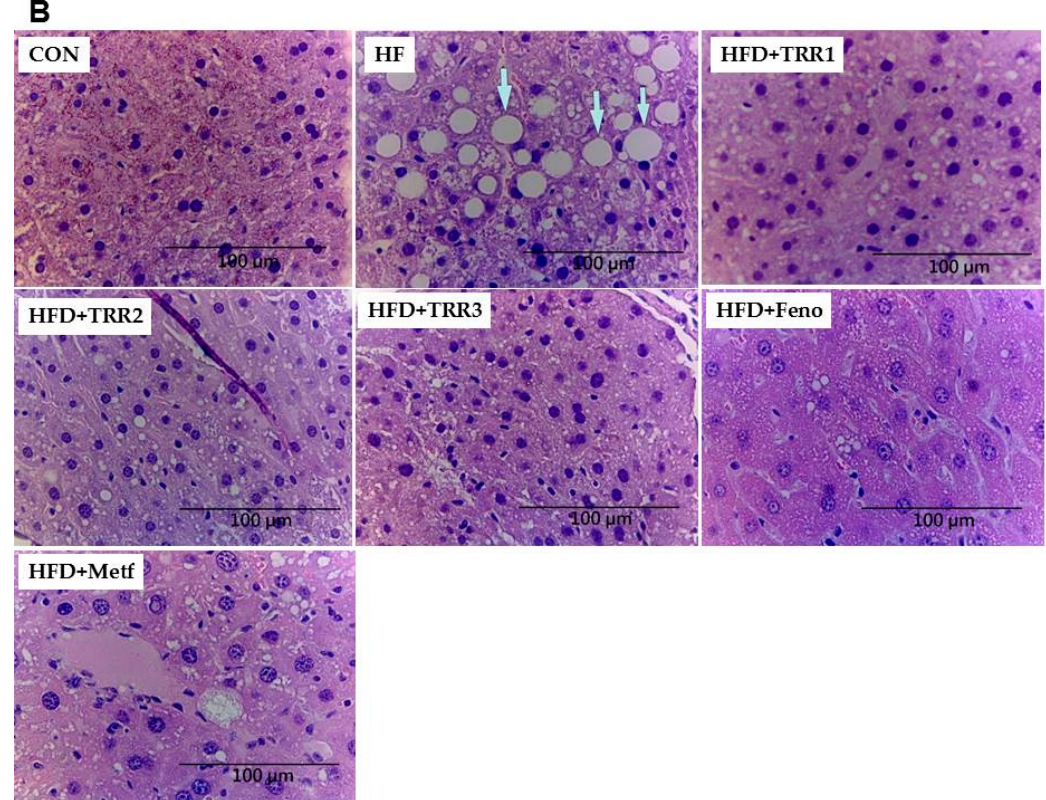
Figure 4. Histology of ( A ) epididymal white adipose tissue and ( B ) liver tissue of mice in the control (CON), high-fat-diet plus vehicle (distilled water) (HF), HFD + TRR1, HFD + TRR2, HFD + TRR3, HFD + fenofibrate (Feno), or HFD + metformin (Metf) groups by hematoxylin and eosin staining. Arrows indicated the hepatic ballooning degeneration. Each presented is typical and representative of nine mice, and one section per mouse. TRR1, TRR2, or TRR3: 10, 20, or 40 mg/kg body weight eburicoic acid, respectively Feno: Fenofibrate (250 mg/kg body weight); Metf: Metformin (300 mg/kg body weight).